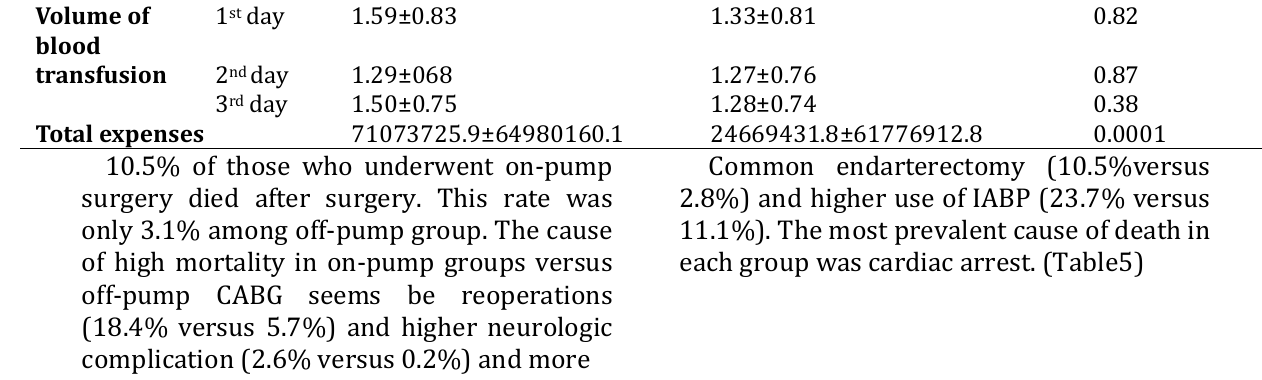
each group was cardiac arrest. (Table5)